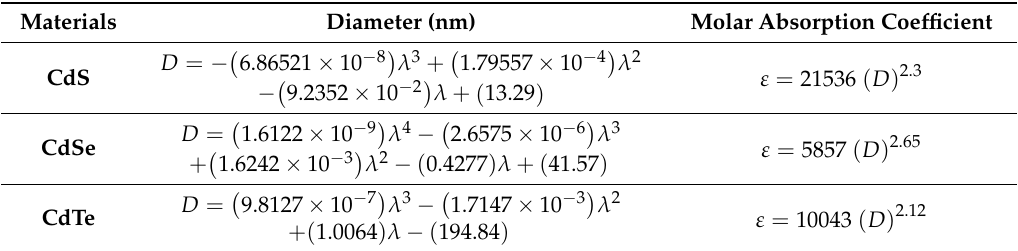
Table 1. Optical properties and diameters of CdS, CdSe, and CdTe